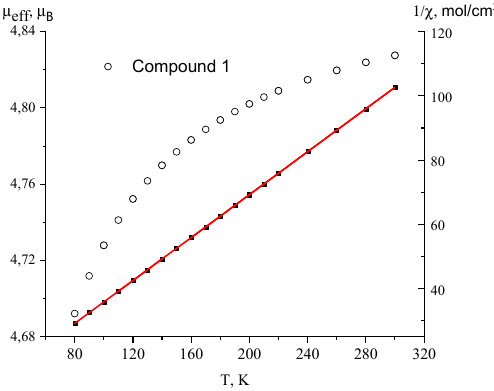
Figure 5. Temperature dependencies of the µ e ff ( theoretical